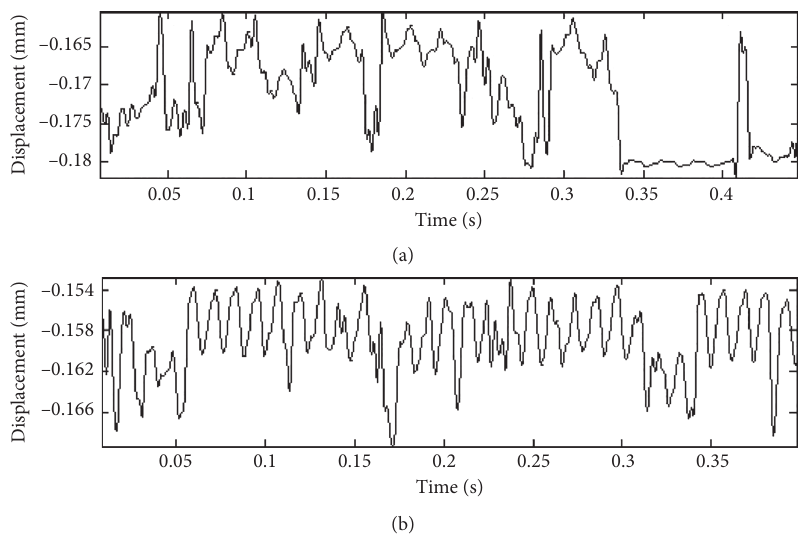
Figure 20: y -axis position of the rotor. (a) The rotor was running at 4800rpm. (b) The rotor was running at 5000rpm.